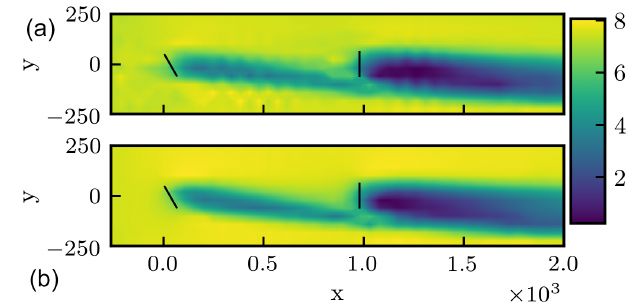
Figure 2. Time-averaged velocity magnitude fields at the tur- bine hub height associated with the low- and high-fidelity mod- els. Panel (a) shows the flow field associated with the low-fidelity model, and panel (b) shows the flow field associated with the high- fidelity model. In both cases, the front turbine is offset by 30 ◦ , and the back turbine has no yaw offset. Brighter colors correspond to faster velocity magnitudes. Turbine positions are shown with dark